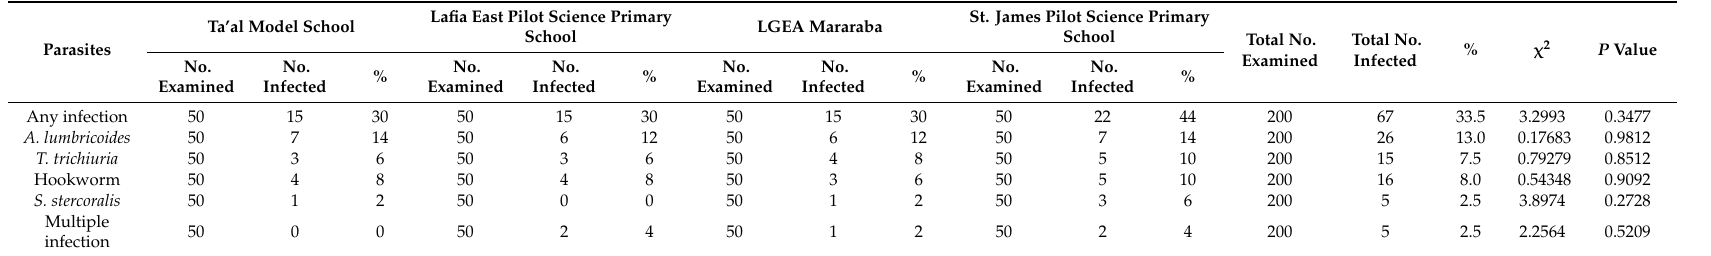
Table 2. Prevalence of soil-transmitted helminth parasites in the four selected public